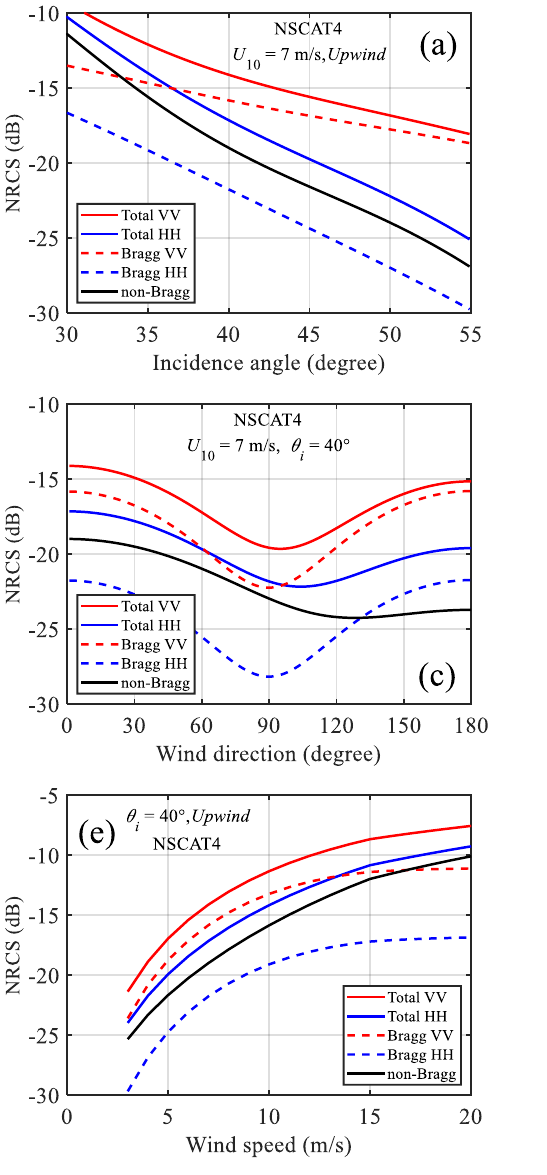
Figure 5. The NRCSs of total scattering, “pure” Bragg wave scattering and non-Bragg scattering, and the relative contribution of non-Bragg scattering estimated by using the NSCAT4. ( a , b ): with respect to incidence angles, ( c , d ): with respect to wind directions, ( e , f ): with respect to wind speeds.